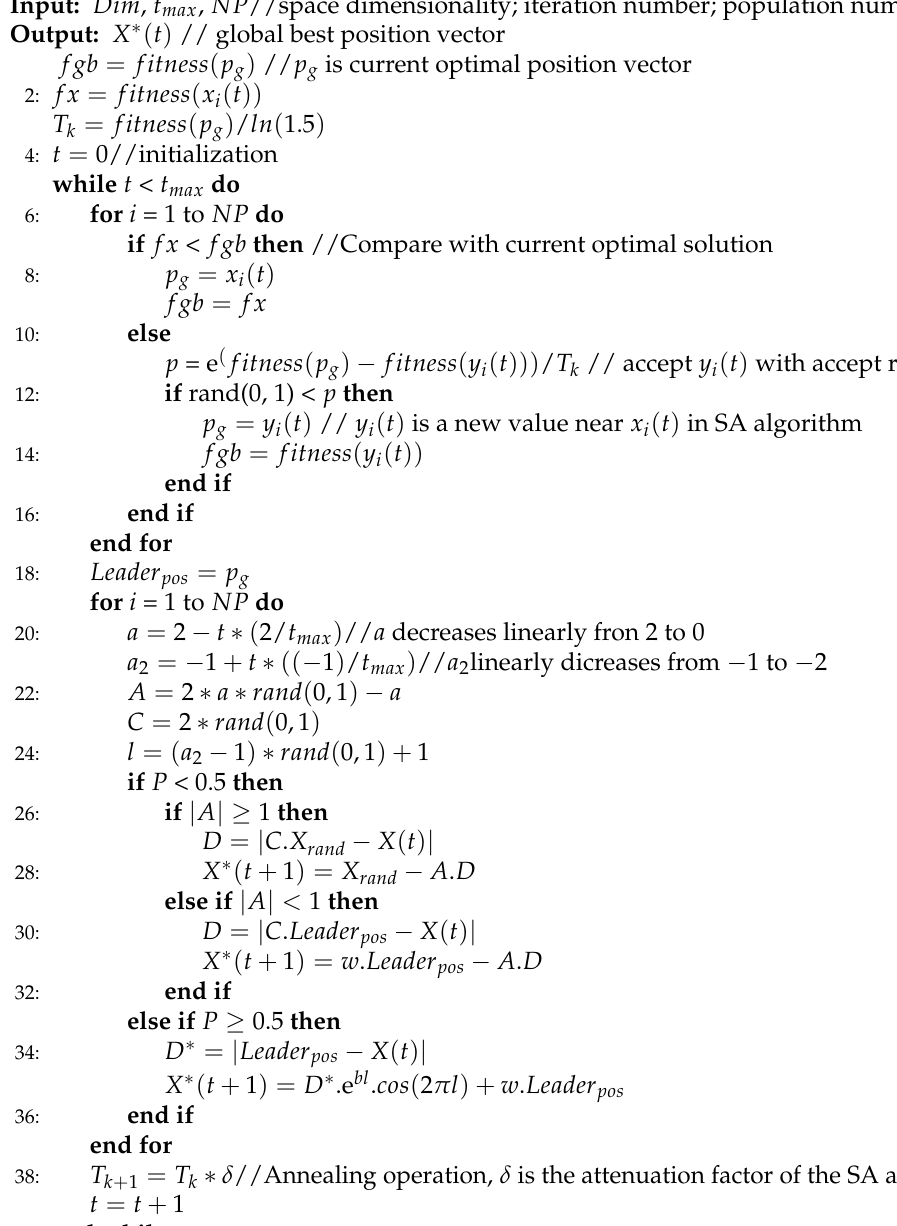
Algorithm 2 IWOA-SA main